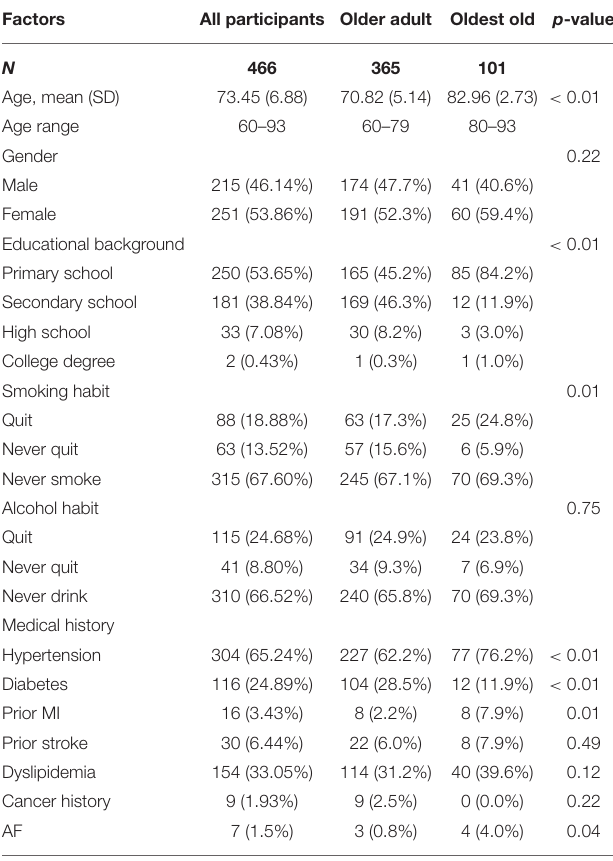
TABLE 1 | Baseline characteristics of the participants in our study.